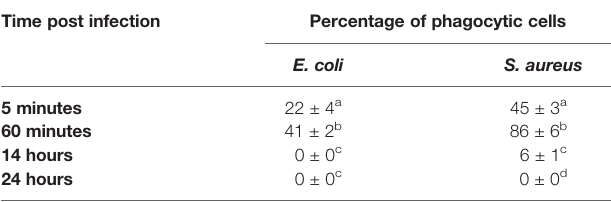
Values represent mean ± s.e.m. Different letters indicate statistically signi fi cant differences among cells undergoing phagocytosis (E. coli or S. aureus) and non-phagocytic cells at different time points (One-Way ANOVA: for E. coli F 3-11 = 876.8, p < 0.0001; for S. aureus F 3-11 = 910.8, p <